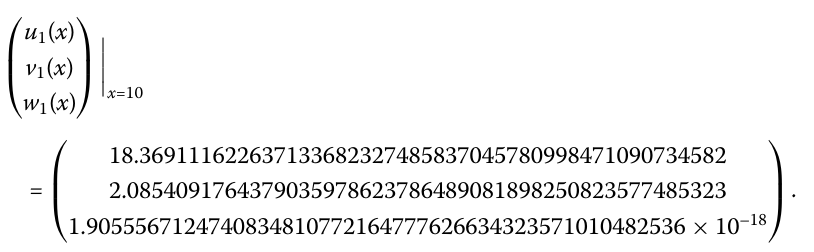
The reference solution of (38) accurate to 30 dp is given at the final mesh point x = 10